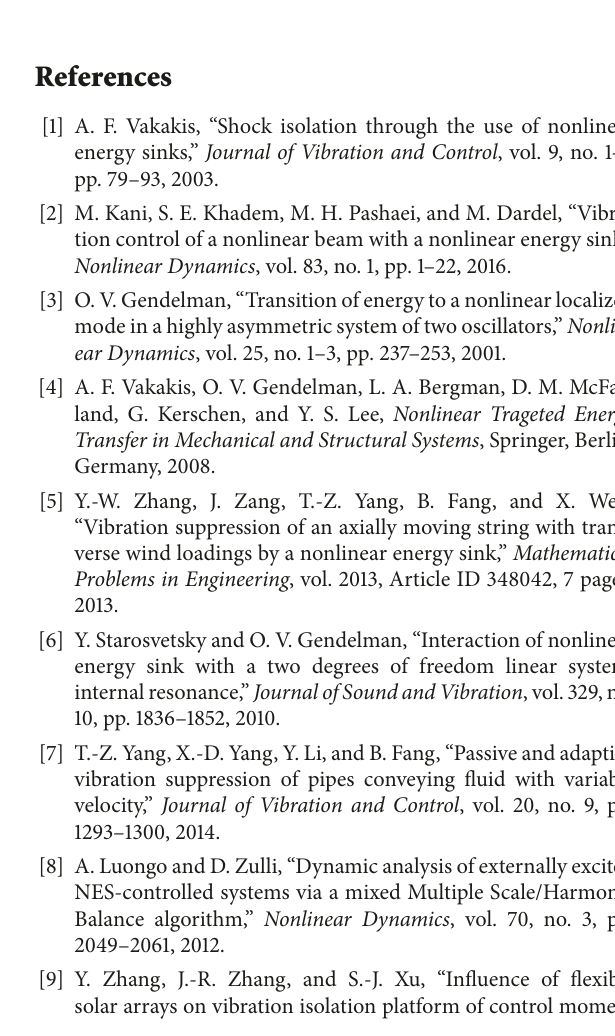
Figure 9: Comparing the transient response of the primary system with NES-piezoelectricity system and without it of (a) configuration 1 and (b) configuration